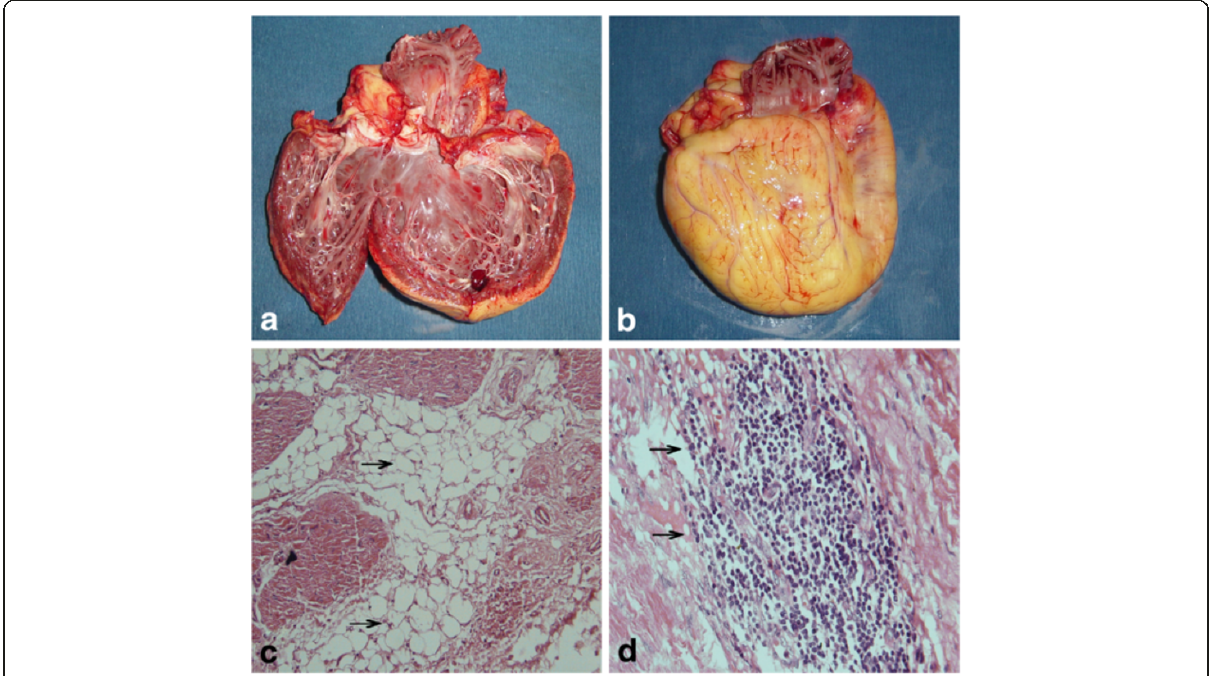
Figure 3 Pathologic findings from explanted heart (gross and microscope examination). a: the resected heart showed severe dilation of RV and thickness and fatty replacement of RV wall; b: the epicardium was surrounded with massive fatty tissues; c: the remnant cardiac muscle was located sporadically with massive fibrolipomatous tissues infiltration and myocardium was isolated like islands and structurally disordered (HE Stain×400), arrows showing fibrolipomatous tissue replacement; d: massive inflammatory cells (small lymphocytes) infiltration were found in the interventricular septum under higher magnification (arrows, HE